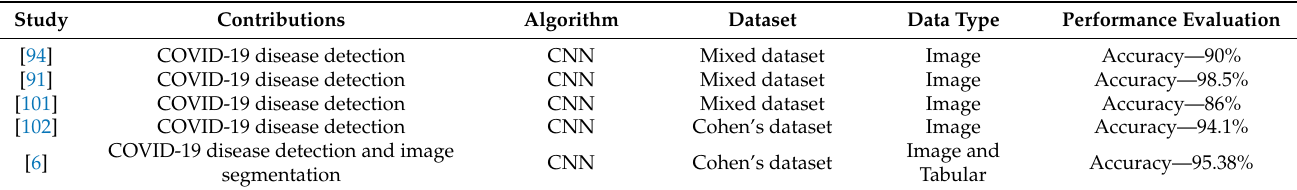
Table 8. Referenced literature that considered machine-learning-based COVID-19 disease diagnosis.